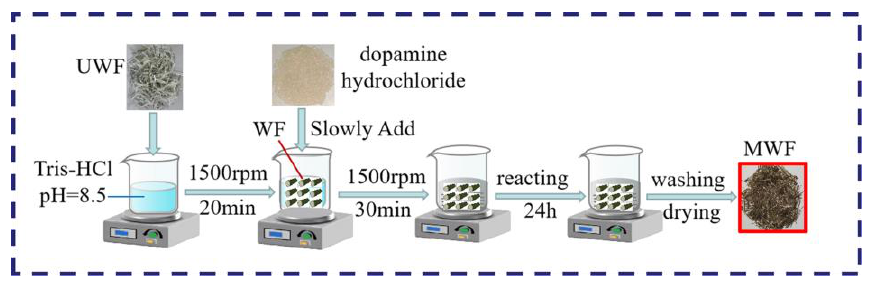
Figure 2. The surface modification flowchart of the waste glass fibers.